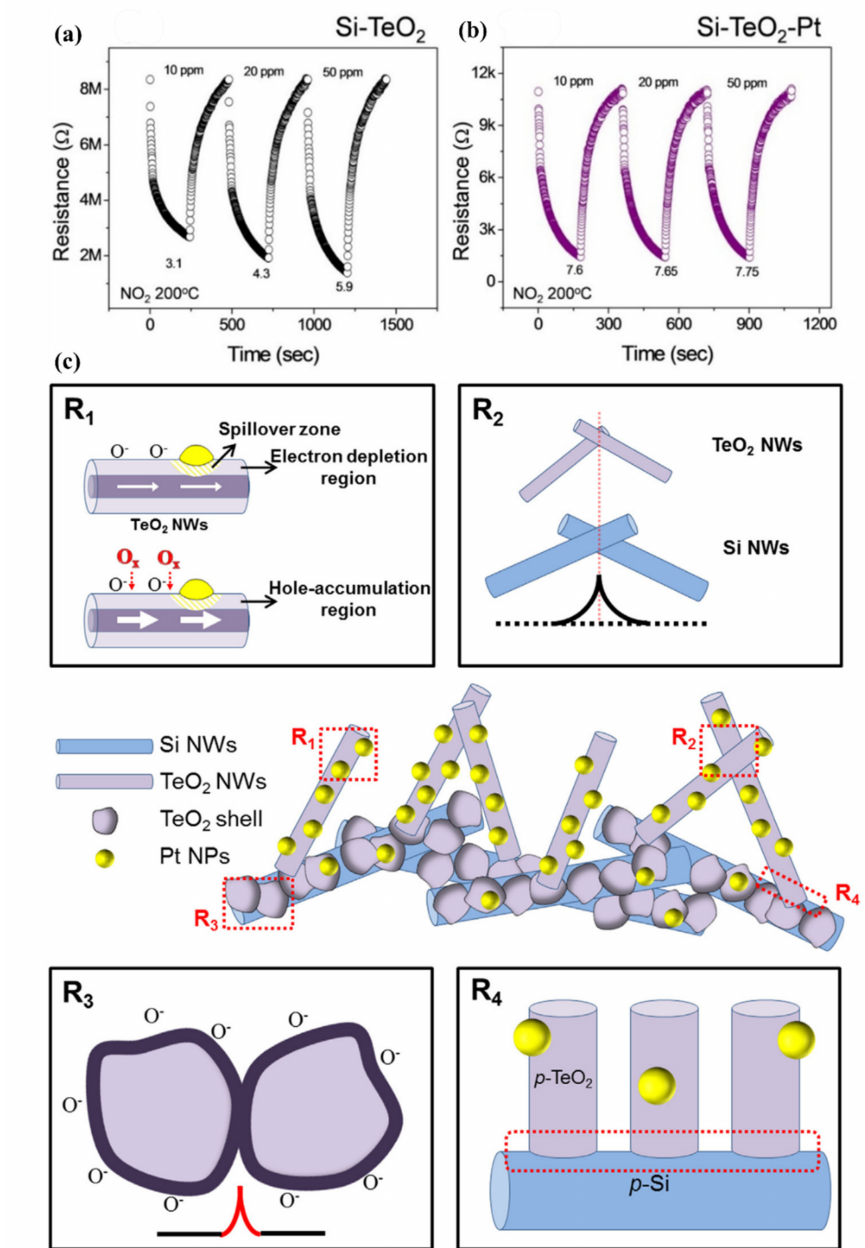
Figure 33. Dynamic resistance curves of ( a ) pristine and ( b ) Pt-functionalized branched nanowires at NO 2 concentrations of 10, 20, and 50 ppm. ( c ) Schematic diagram showing the four resistance mechanisms operating in Pd-functionalized branched nanowires: (R 1 ) modulation of depletion width along the branched TeO 2 nanowires (including additional Pt e ff ects), (R 2 ) modulation of the potential barrier at networked homojunctions between branched TeO 2 nanowires, (R 3 ) modulation of the potential barrier at boundaries of the nanograins, and (R 4 ) modulation of the potential barrier at Si-TeO 2 heterojunctions. Reproduced from [176], with permission from Elsevier,